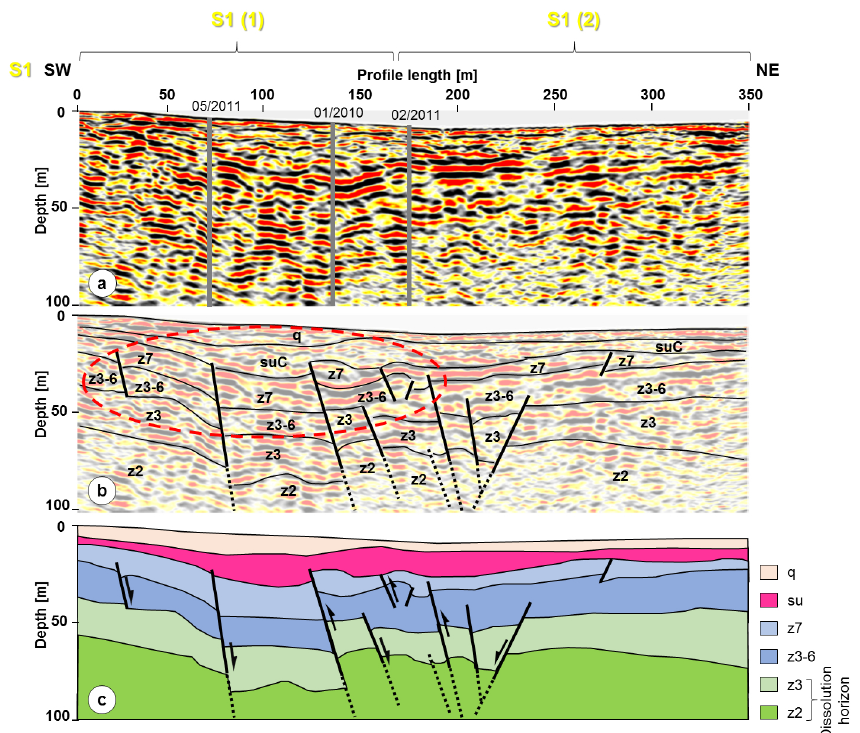
Figure 6. Uninterpreted reflection-seismic profile S1 (a) with stratigraphy derived from boreholes 05/2011, 01/2010 and 02/2011 (b) and with interpretation (c) . The stratigraphic units are explained in Fig. 3. The profile was surveyed north of the sinkhole. Besides local thickening of sediments and thinning of evaporites, several steep-dipping normal and reverse faults within the Permian and Triassic deposits were identified. In the south-west a bowl-shaped structure is visible (red dashed circle), which was interpreted as a dissolution-induced